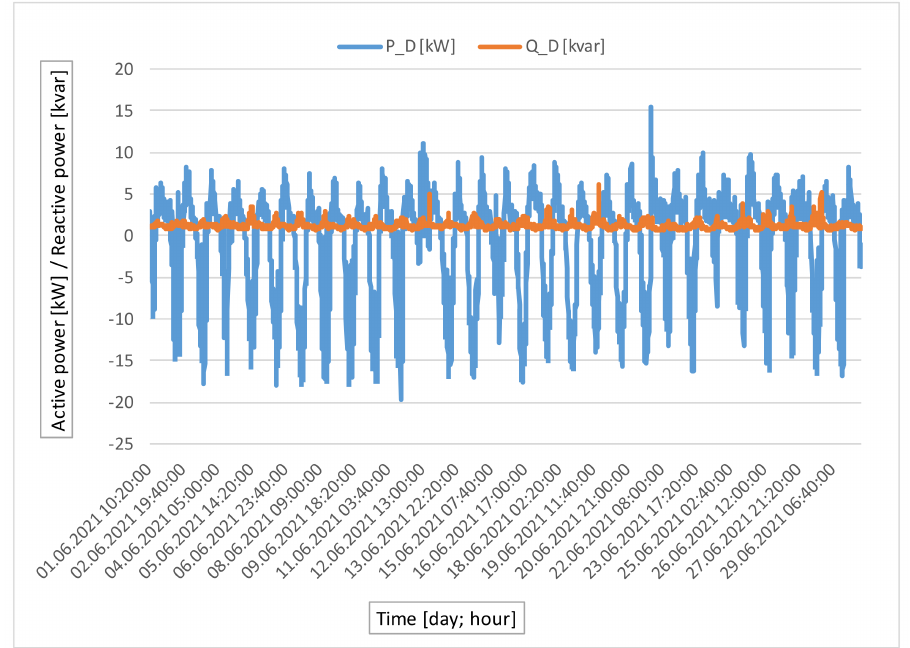
Figure 10. Active P D and reactive Q D power variations; period 1 June 2021, hour 10:20 a.m. − 29 June 2021, hour 6:40